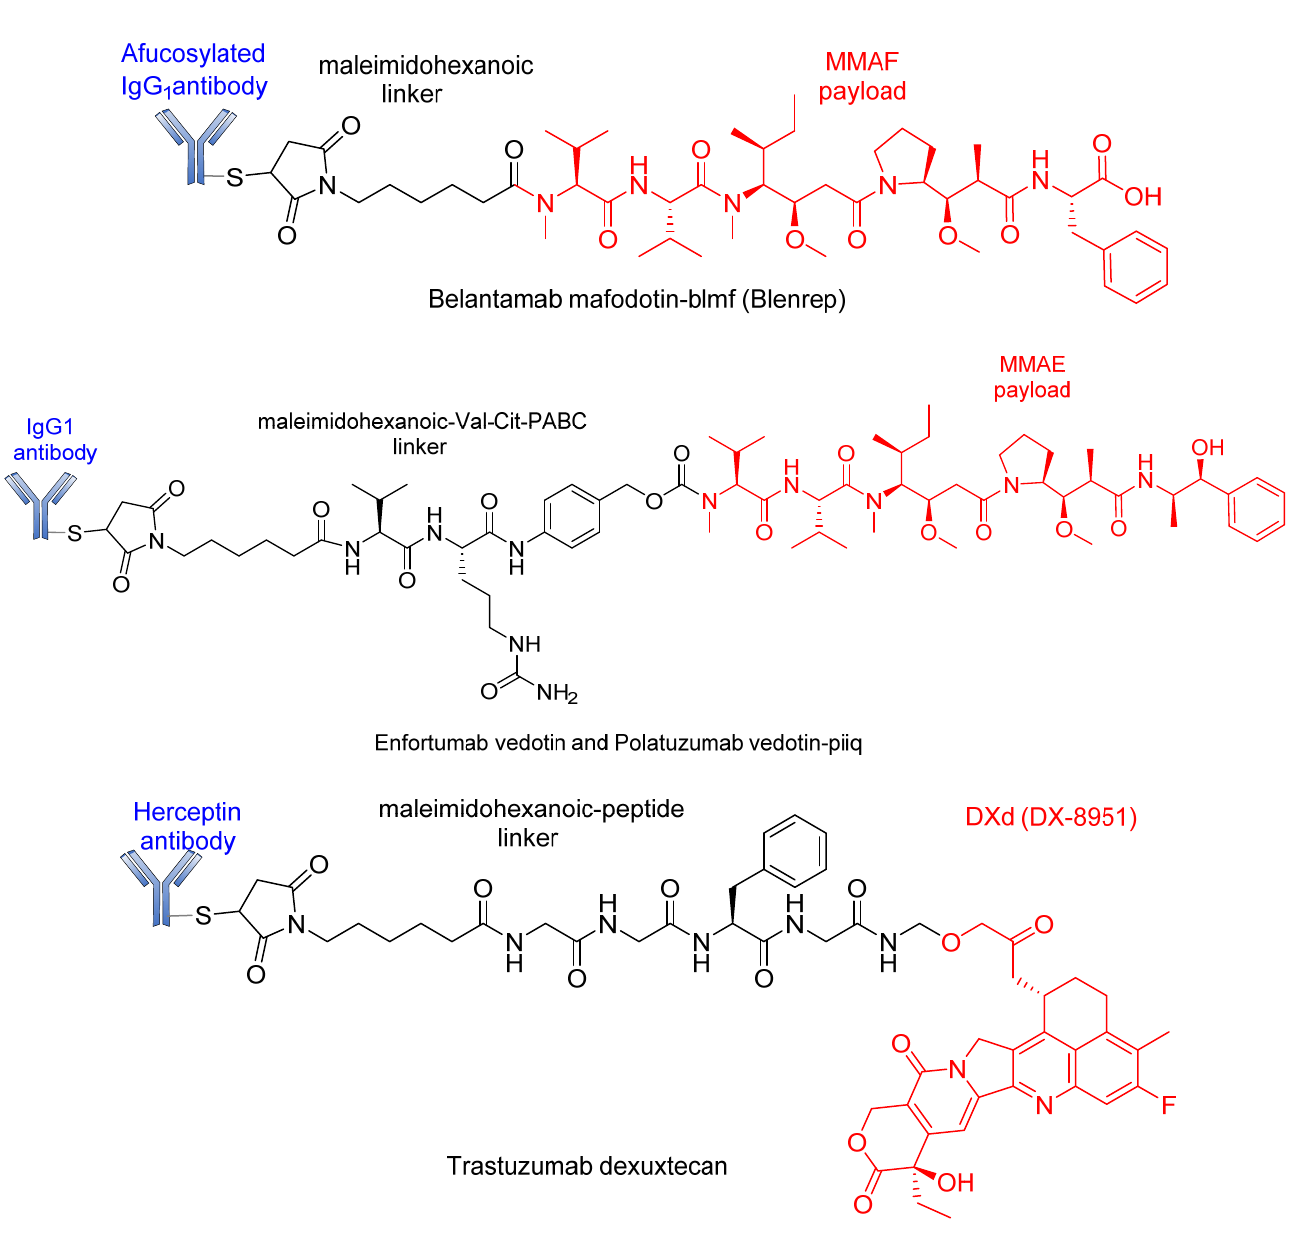
Figure 21. Chemical structures of some recently approved ADCs.